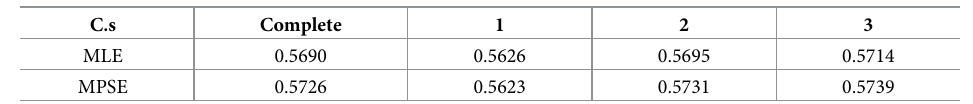
Table 13. Estimates of θ for example 1.